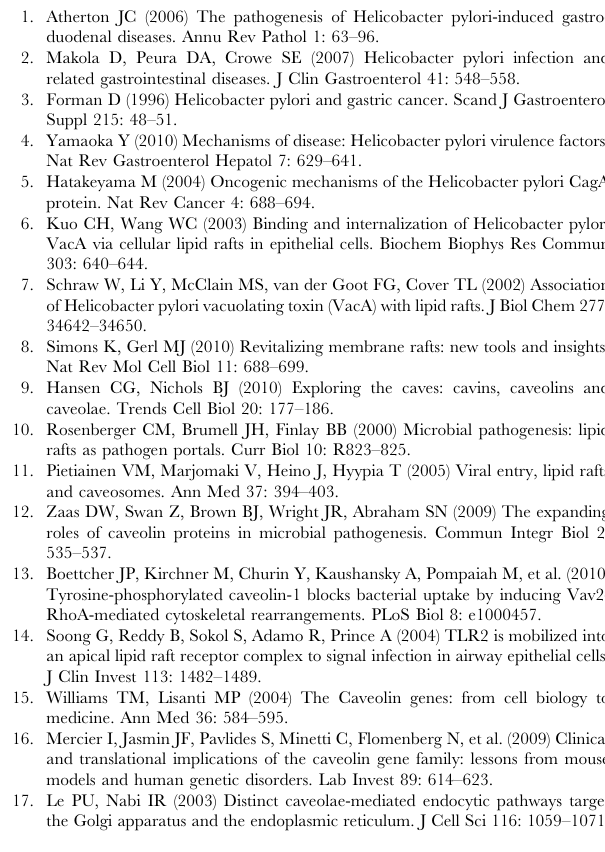
Figure S2 Cav1 promotes cell adhesion and wound closure in vitro . (A) Cell adhesion. AGS/Cav1 and AGS/EV cells were seeded on tissue culture dishes for 6 h. The number of adherent cells was counted as mean 6 S.E. (n= 3); *p =0.0394, Cav1 versus EV. (B) Wound closure. Confluent AGS/Cav1 and AGS/EV cell monolayers were injured by a 5 mm wide scratch.